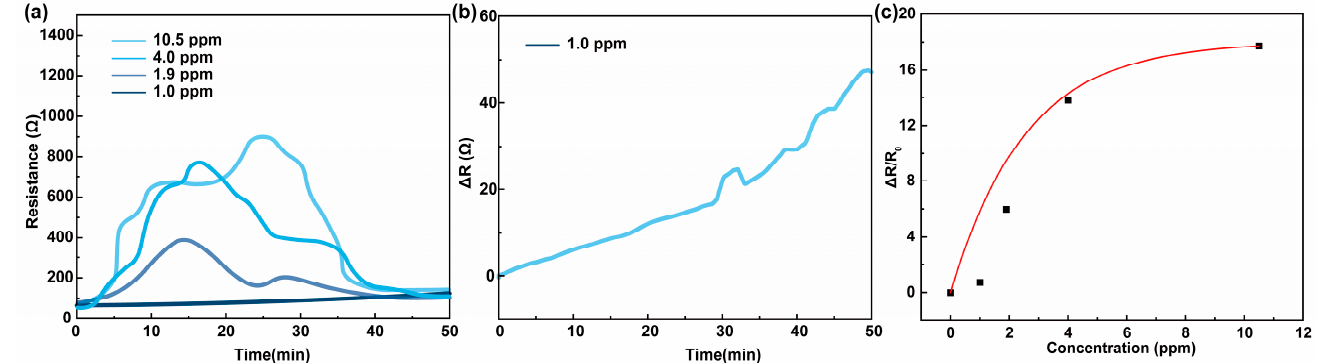
Figure 7. ( a ) Resistance-time curve to different concentrations of HPV, ( b ) resistance change-time curve to 1.0 ppm HPV and ( c ) resistance response-HPV concentration fitting curve of PE- DOT:PSS/PEDOT (30 mC) film. Table 1. Comparison of resistance response ( Δ R/R 0 ) of PEDOT:PSS and PEDOT:PSS/PEDOT films under different concentrations of HPV. HPV (ppm)